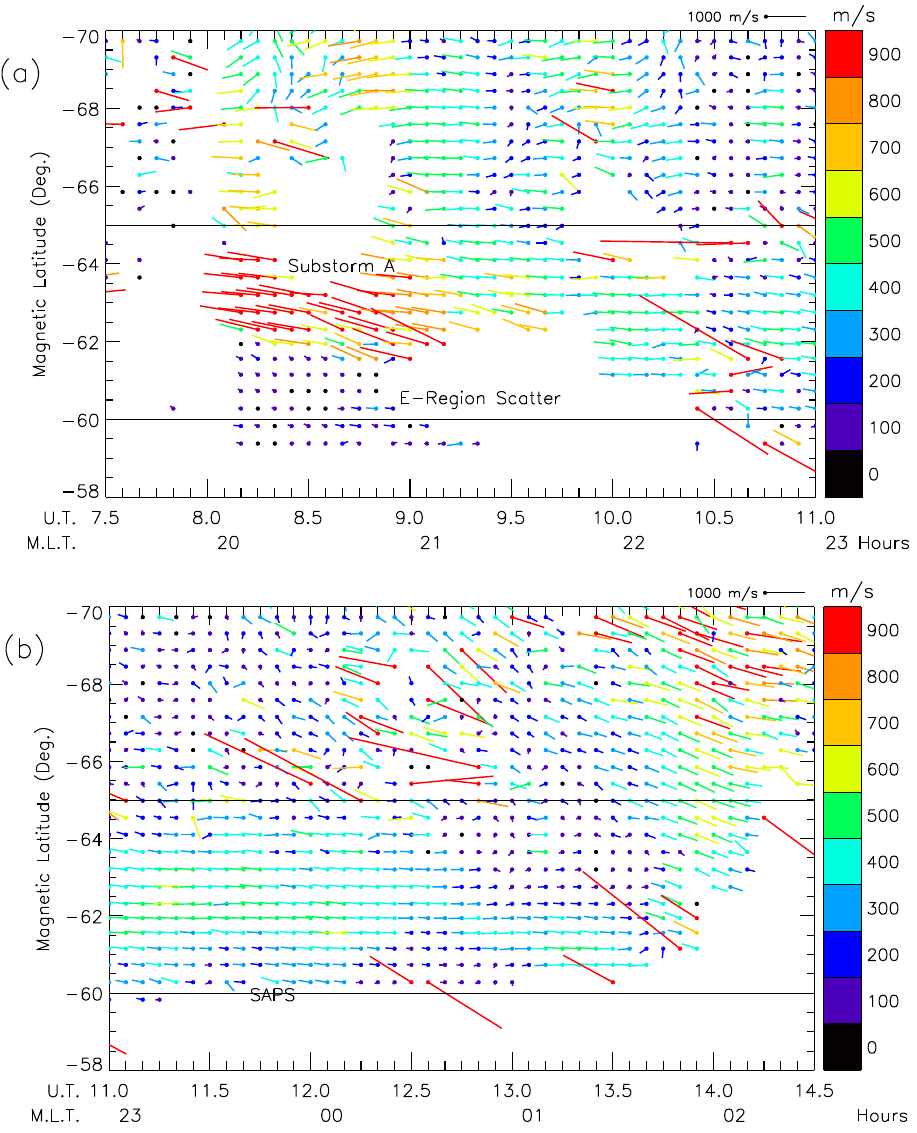
Fig. 6. (a) Two-dimensional flow vectors estimated along TIGER beam 4 using the beam-swinging technique at 5-min time resolution during 07:30 to 11:00 UT on 30 November 2002. The solid dots identify the time and latitude of the velocity estimate, and the lines point in the direction of the flows. Flows directed toward the right were eastward, and toward the bottom, equatorward. The flow speeds are colour coded from < 50ms − 1 (black) to > 850ms − 1 (red). Tick marks are at 5-min intervals. (b) The same as Fig. 6a except for the interval 11:00 to 14:30 UT on 30 November